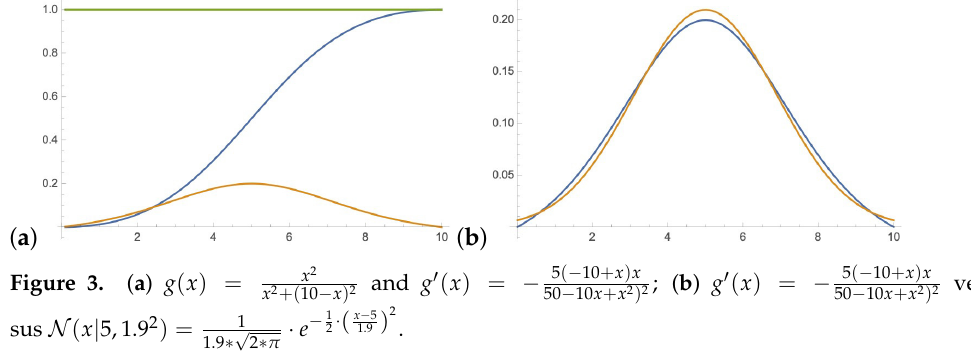
sus N ( x | 5,1.9 2 )